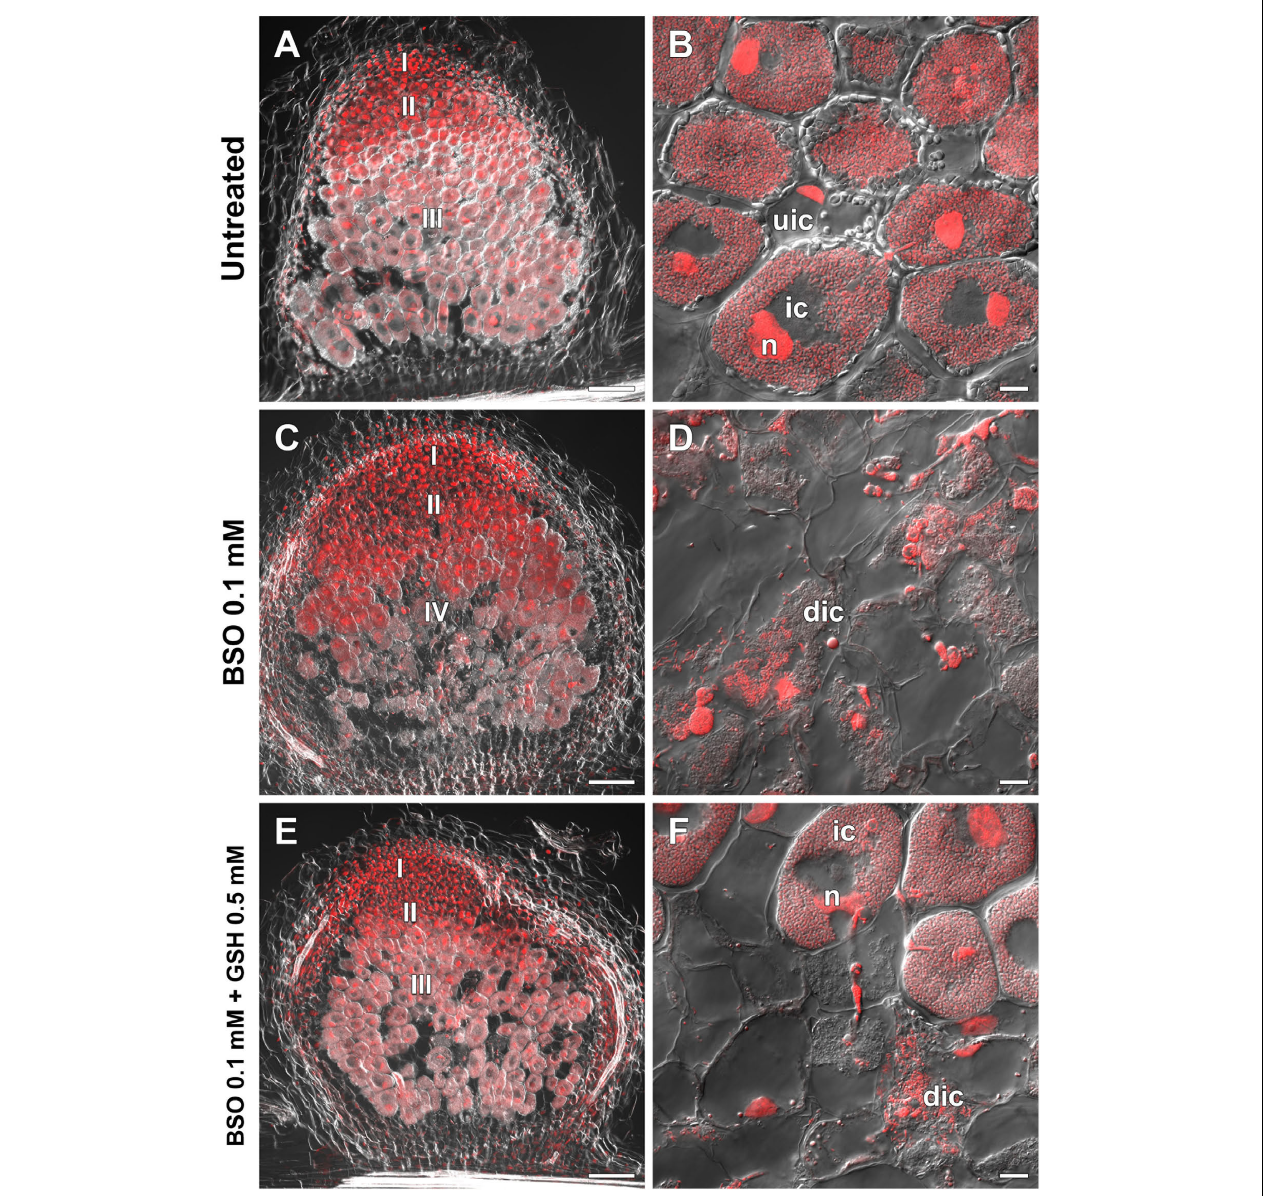
FIGURE 8 | Two-week-old nodules from wild-type pea ( Pisum sativum ) plants treated with L-buthionine-sulphoximine (BSO) and glutathione (GSH). (A,C,E) General view; (B,D,F) infected cells. (A,B) untreated nodules; (C,D) nodules on plants treated with 0.1 mM BSO; (E,F) nodules on plants treated with 0.1 mM BSO and 0.5 mM GSH. Confocal laser scanning microscopy images of 50- µ m-thick longitudinal sections. Merge of differential interference contrast and the red channel. A single optical section is presented. DNA (bacteria and nuclei) is shown in red. I, meristematic zone; II, infection zone; III, nitrogen fixation zone; IV, senescence zone; n, nucleus; ic, infected cell; uic, uninfected cell; dic, degrading infected cell. Scale bars = 100 µ m (A,C,E) and 10 µ m (B,D,F)